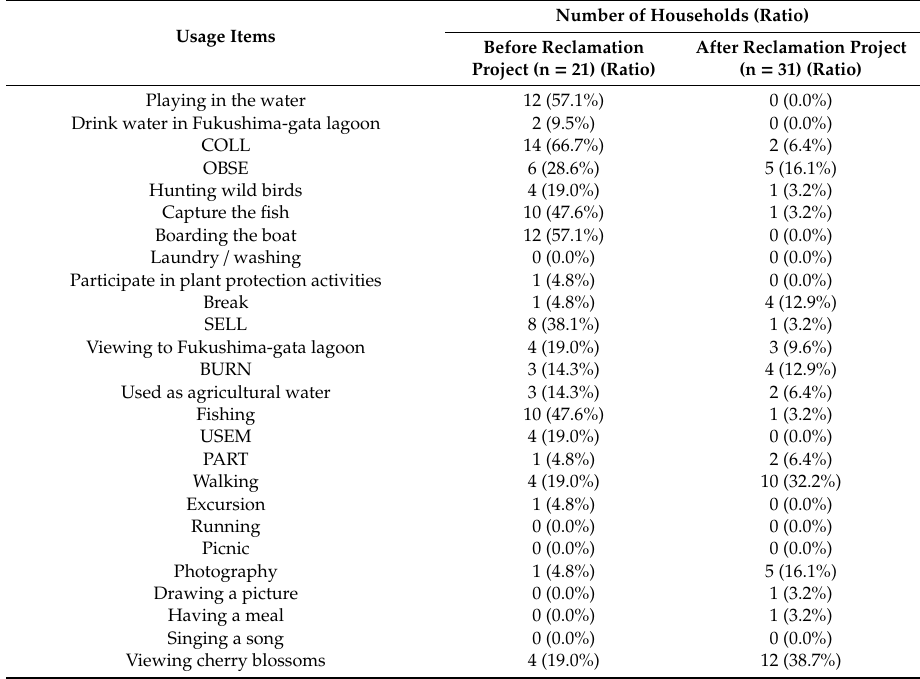
Table A3. The actual situation of uses of the Fukushima-gata lagoon before and after the reclamation project (n =